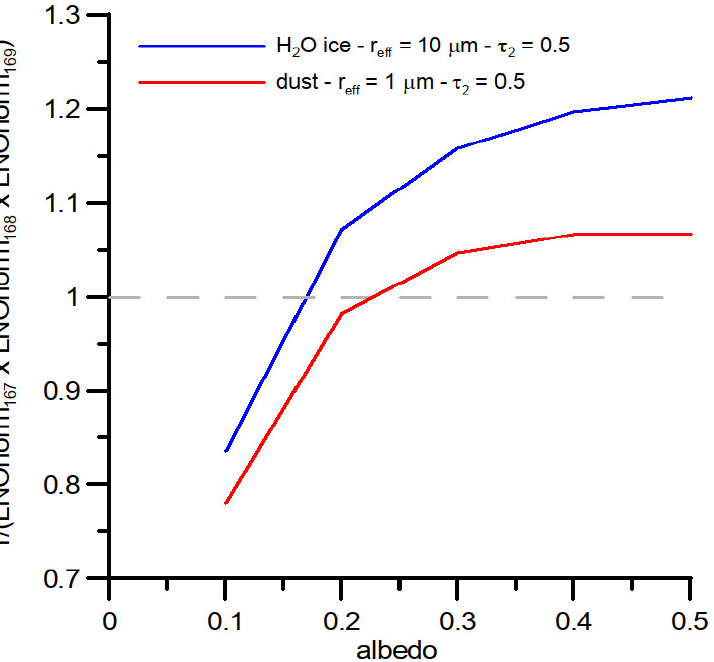
Figure 3. Simulated FCI vs. arbitrary albedo obtained by the MITRA tool. The simulations have been performed for water ice (in blue) and dust (in red) using orders 167, 168 and 169.